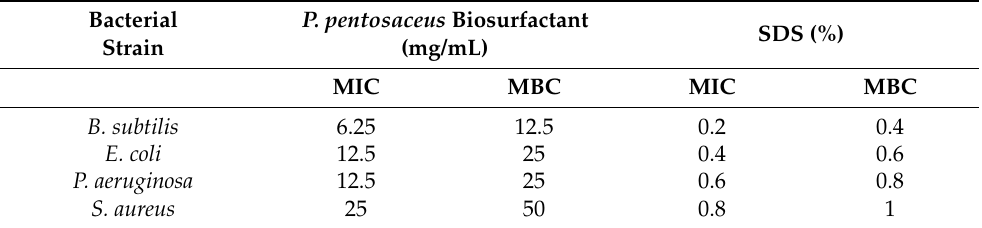
Table 2. Antibacterial activity of the P. pentosaceus crude biosurfactant and standard SDS